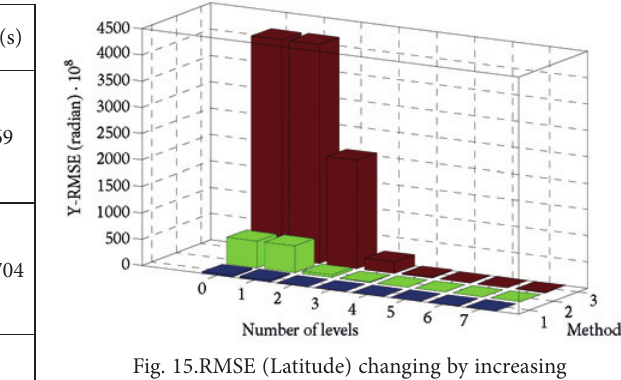
Fig. 15.RMSE (Latitude) changing by increasing termination criterion (a)